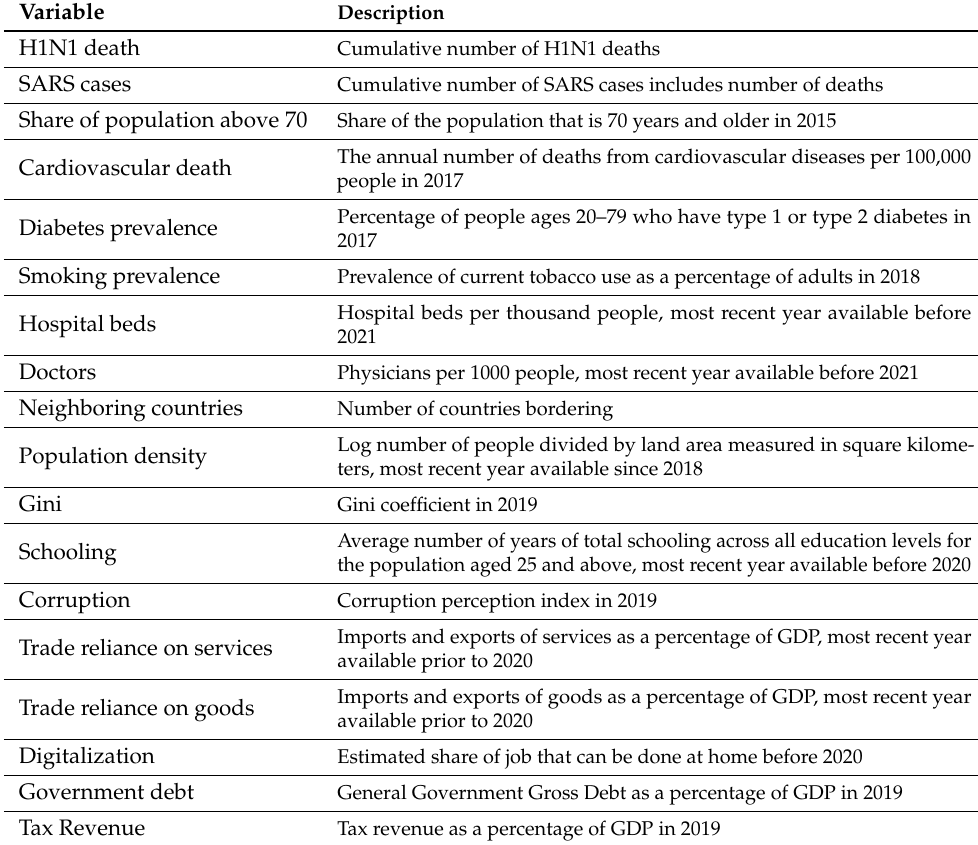
Table A1. Variable descriptions: structural